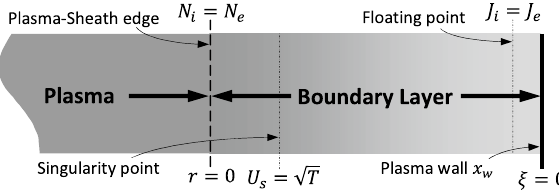
Figure 1. Schematic graph of the simulation zones in the plasma boundary